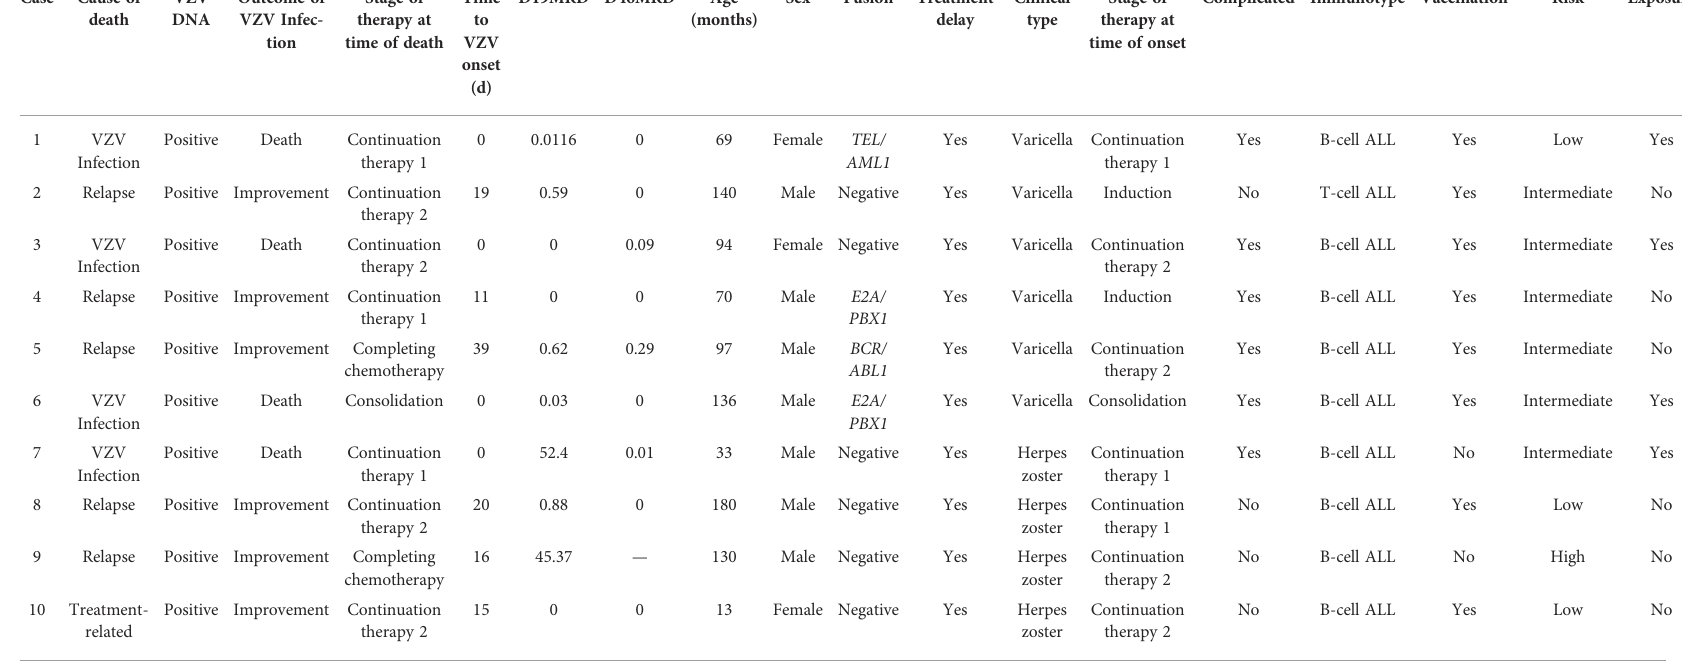
TABLE 4 Detailed information of patients died either VZV infection or other causes. Case Cause of